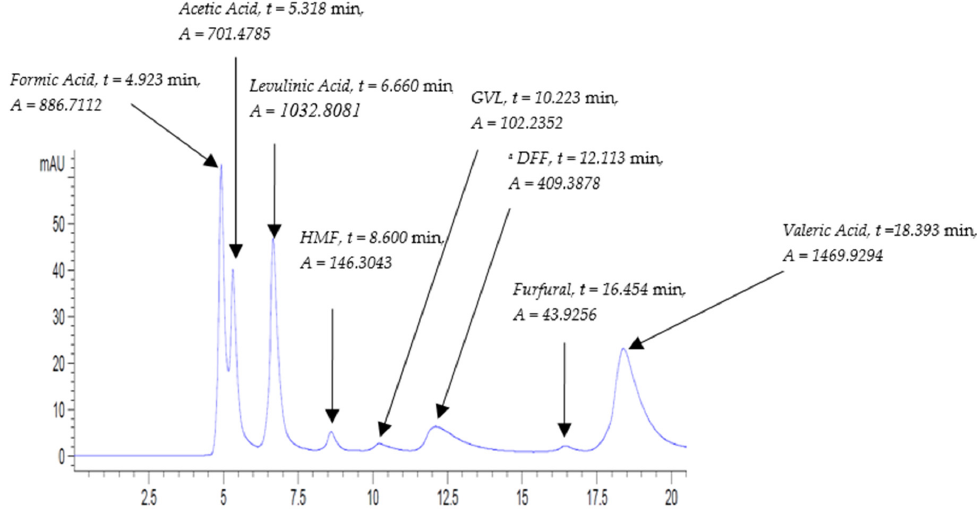
Figure 8. Mixed standard solution ‘Biomass’ chromatogram at UV-210 nm at the following conditions: flow rate, 0.5 mL/min; column temperature, 30 °C; and run time, 20 min. a: DFF: Diformylfuran.